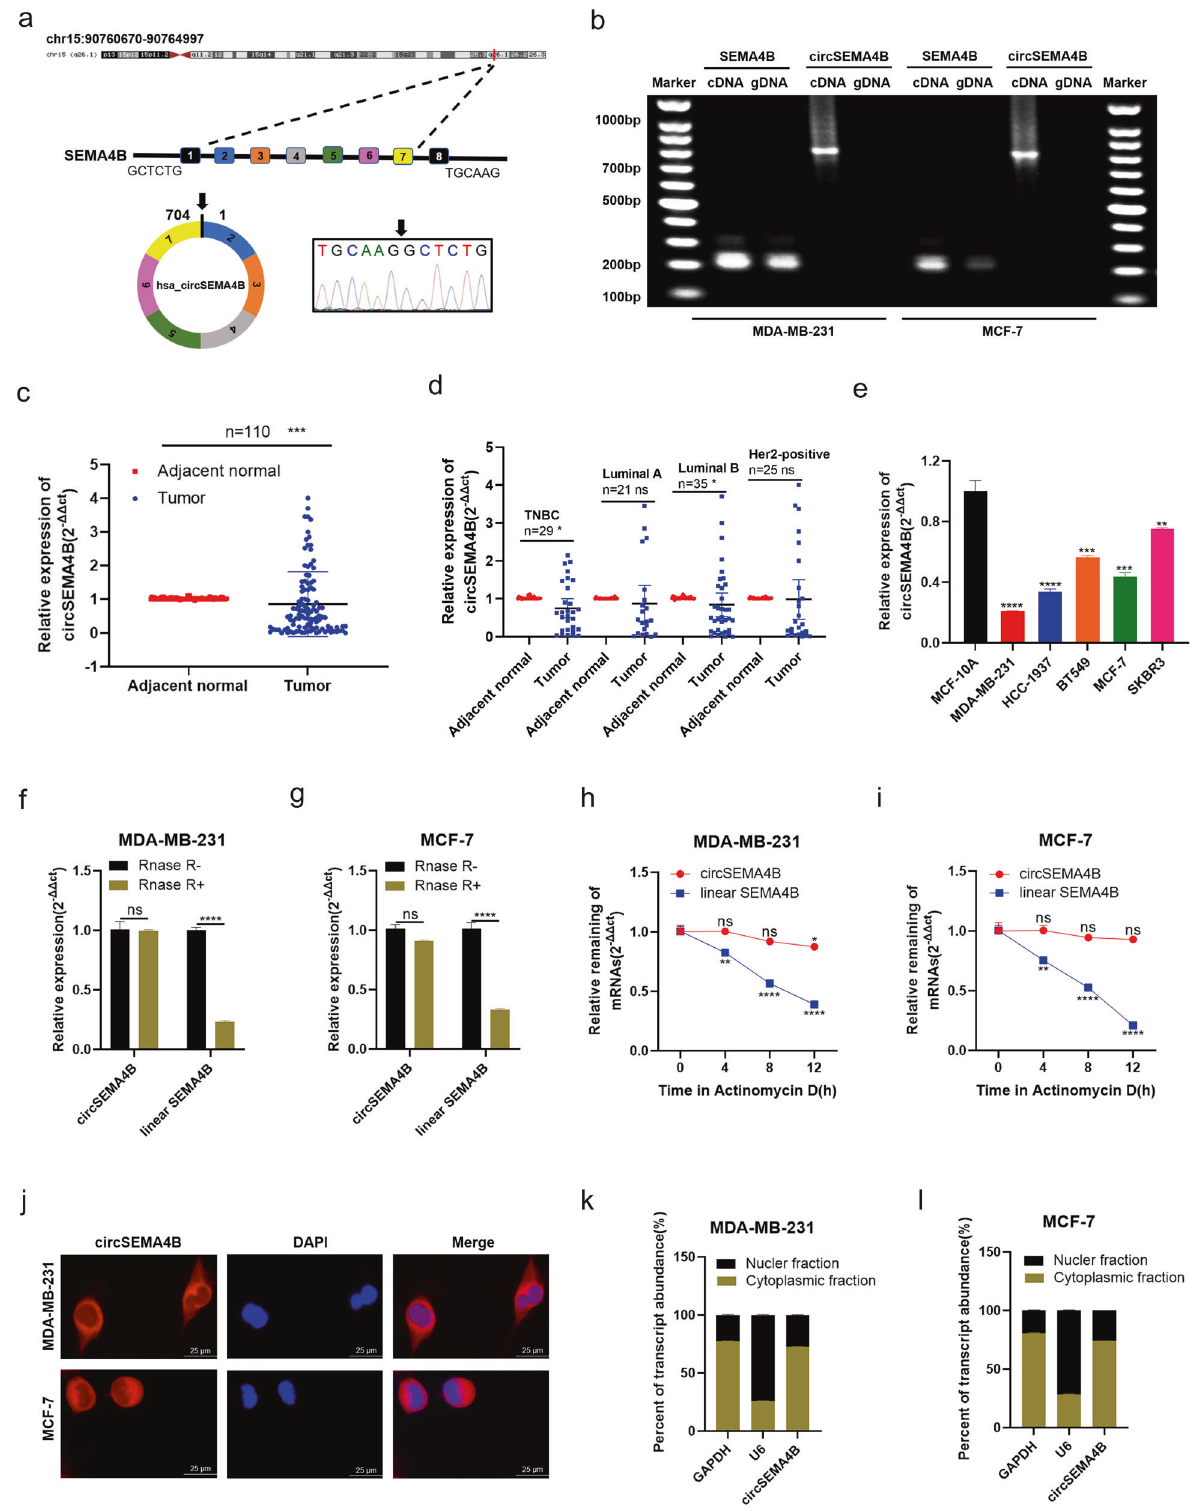
Fig. 1 Characterization of circSEMA4B in BC tissues and cell lines. a circSEMA4B is formed by circularization of exon 2 – 7 of the gene SEMA4B, and the splicing junction was veri fi ed by Sanger sequencing. b Existence of circSEMA4B in BC cells was veri fi ed by agarose gel electrophoresis. c circSEMA4B had low expression in tumor tissues compared with adjacent normal tissues. d Expression of circSEMA4B in TNBC cohort, Her2-positive cohort, luminal-A, and luminal-B cohort, respectively. e circSEMA4B had low expression in BC cell lines compared with MCF-10A. f , g qRT-PCR analysis of hsa_circ_0005273 and linear SEMA4B in BC cells treated with RNase R. h , i After Actinomycin D treatment, the mRNA stability of circSEMA4B and SEMA4B in BC cells was determined by qRT-PCR. j RNA FISH for circSEMA4B and nuclei was stained with DAPI. Red, circSEMA4B; blue, DAPI. k , l Expression levels of cytoplasmic control transcripts (GAPDH), the nuclear control transcript (U6), and circSEMA4B were determined by qRT-PCR in the cytoplasmic and nuclear fractions of BC cells. Cell Death and Disease (2022)